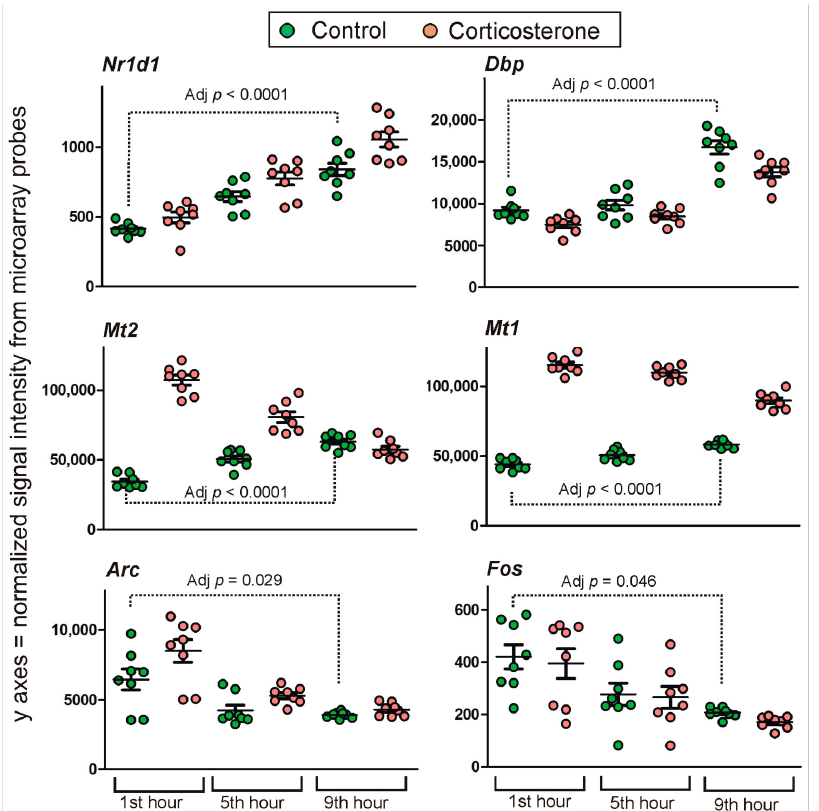
Figure 7. Selected genes displaying significant changes in control animals during the resting period. Y axis indicates probe signal intensity decomposed into green and red channel after final background correction, within-array and between-array normalization. All data are available in File